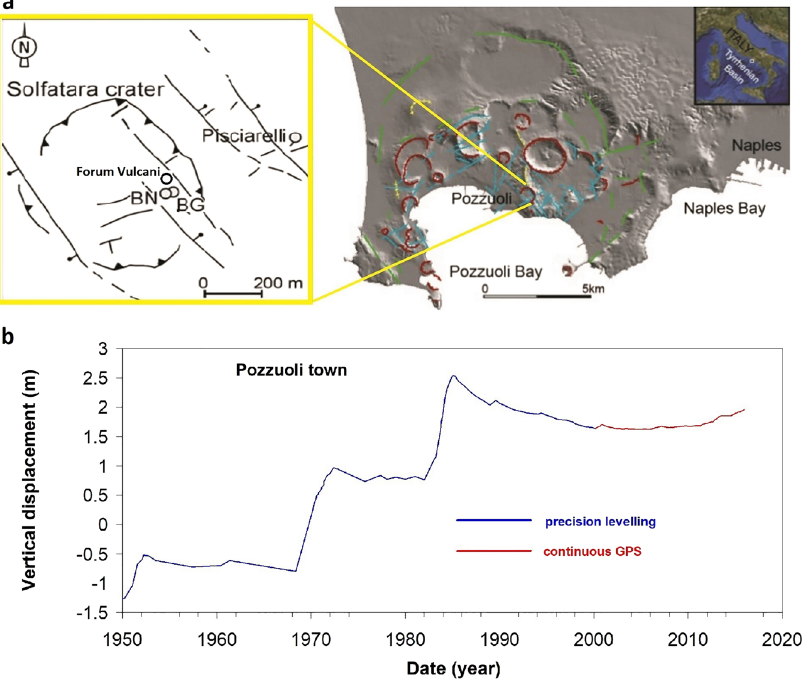
Figure 1. CFc setting and long-term ground displacement. ( a ) Location and structural sketch of Campi Flegrei caldera. Also reported are locations of (2) present Solfatara main fumaroles, Bocca Grande (BG), Bocca Nuova (BN), plus Forum Vulcani, which collapsed during the 1982–84 unrest, and (2) the Pisciarelli fumarole ( b ). Chronogram of the maximum vertical ground displacement 15,19 . Sharp uplifts characterized unrest episodes occurred in 1950–52, 1969–72 and 1982–84. A 20 year-long subsidence took place at the end of the 1982–84 crisis. A new unrest phase started around year 2005, characterized by a lower uplift rate than during the previous uplift